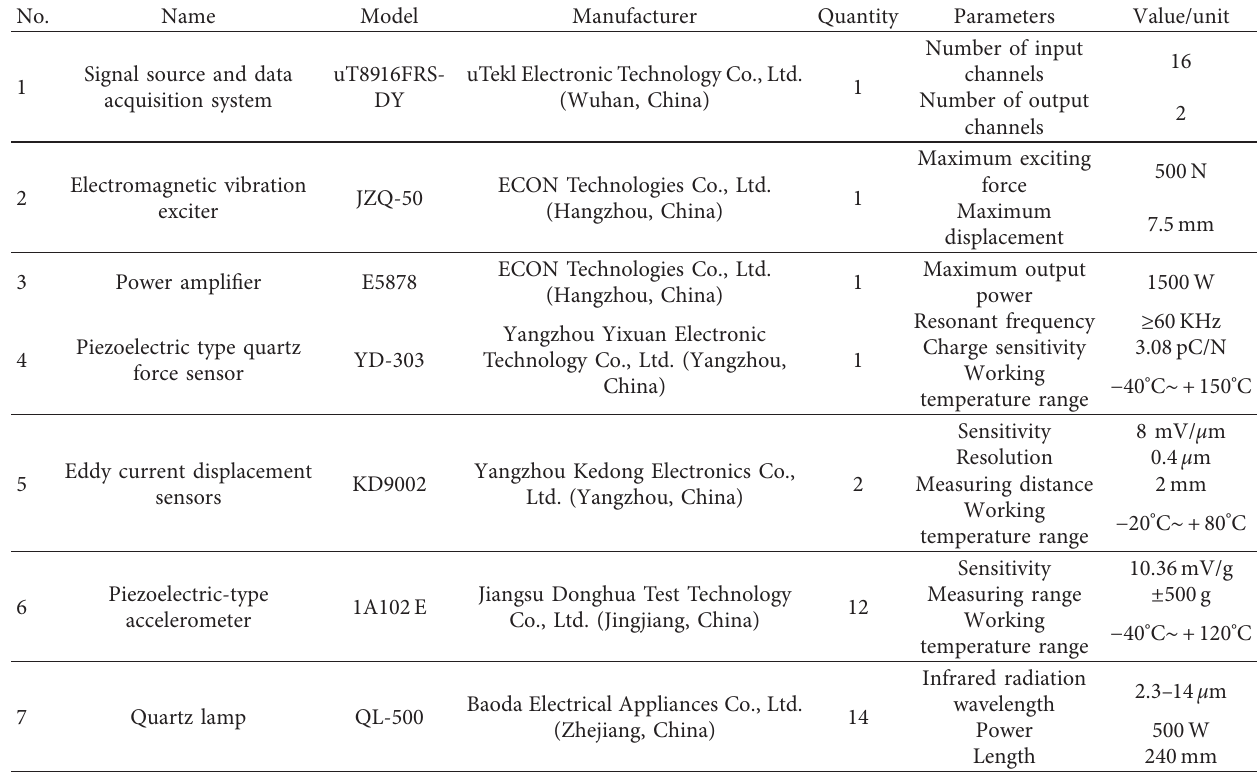
Table 5: Technical specifications of the main equipment for the test system.